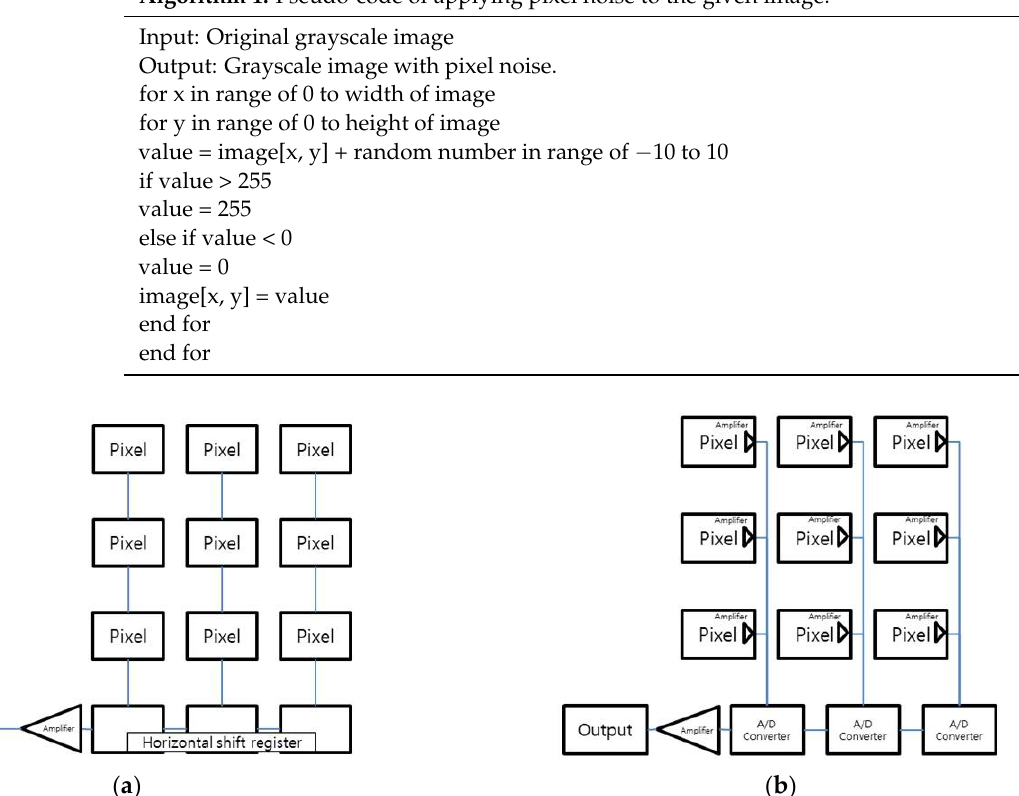
Algorithm 1. Pseudo-code of applying pixel noise to the given image.